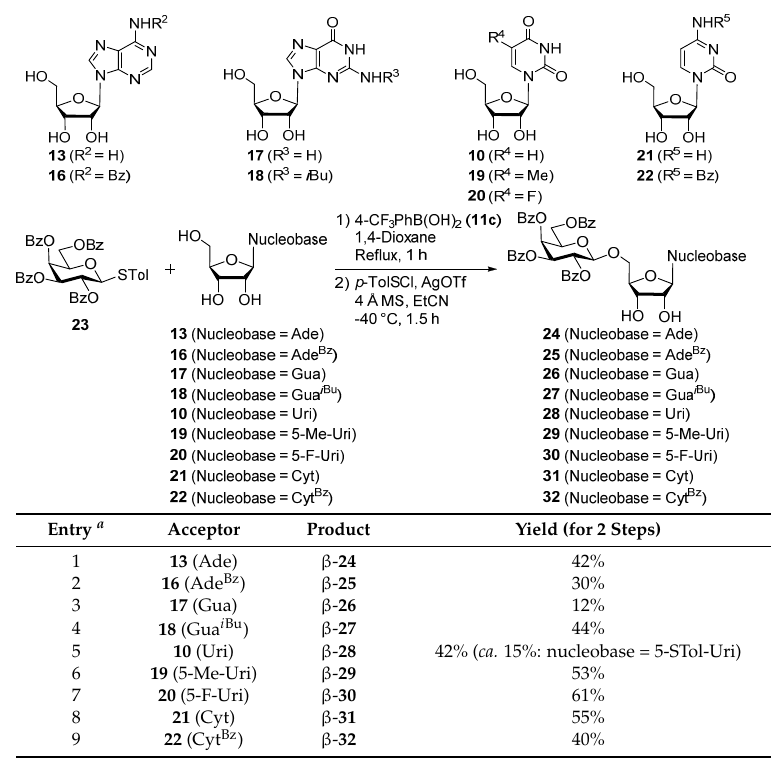
Table 3. O -glycosylation of nucleosides 10 , 13 and 16 – 22 with the thiogalactoside 23 .